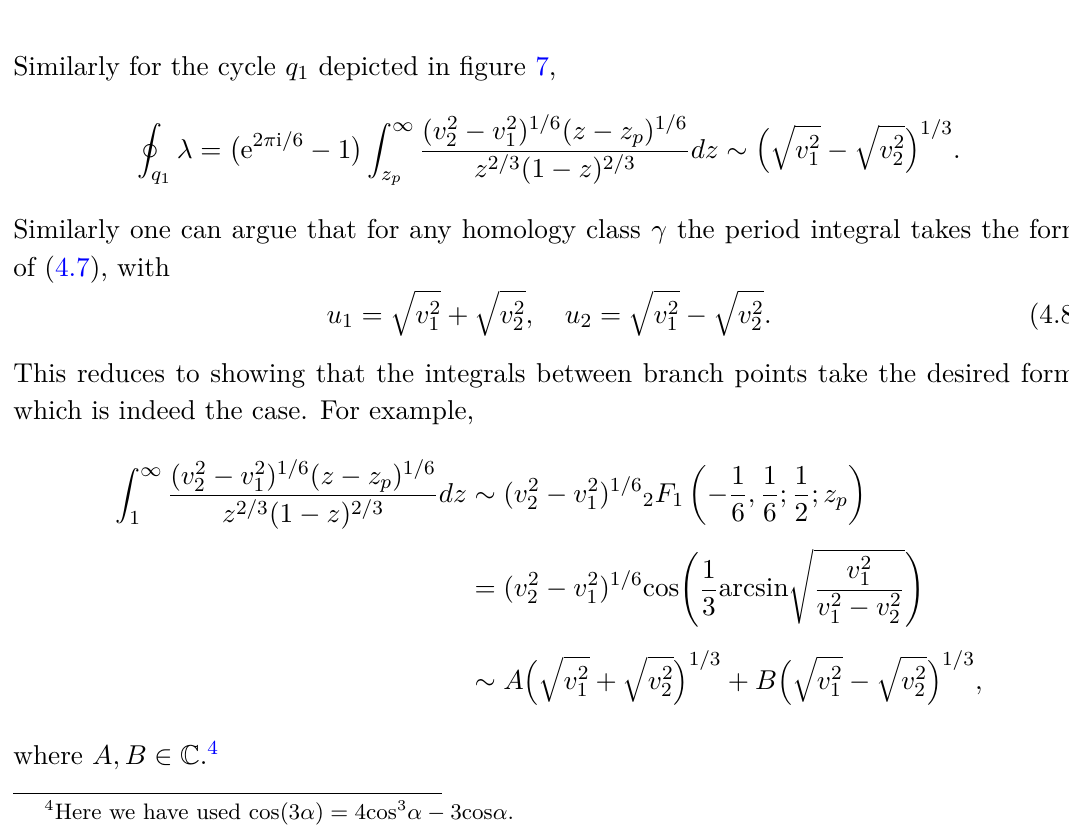
Figure 7 . Choice of branch cuts for Σ 0 and cycles in homology classes p i and q i ( i = 1 , 2 , 3 ) in H 1 (Σ 0 , Z ) . We pick Coulomb branch parameters such that the four branch points are at z 1 = 0 , z 2 = z p , z 3 = 1 and z 4 = ∞ , as shown in this figure. The four branch cuts are represented by wavy lines and they meet at some point on CP 1 . Each branch cut is labeled with the corresponding sheet permutation and the direction to do the